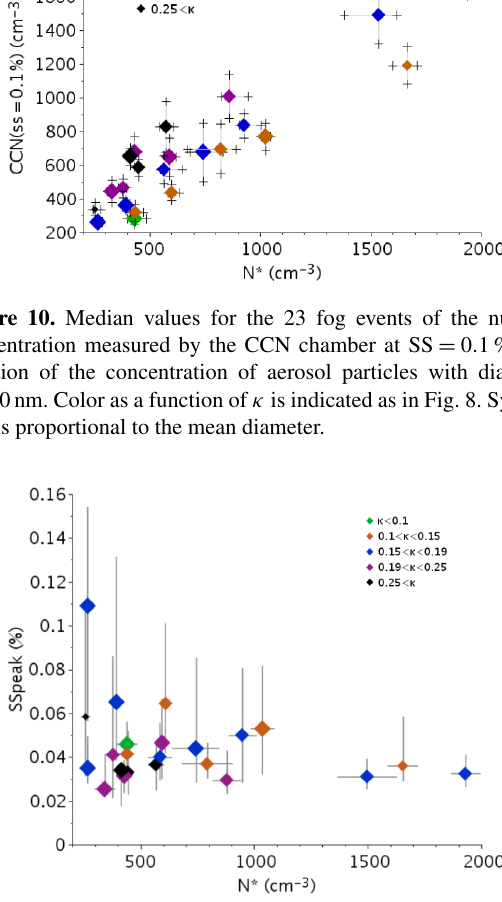
Figure 11. Critical supersaturation as a function of the concentra- tion of aerosol particles with diameter > 200nm for the 23 fog cases. Diamonds correspond to mean values and error bars to un- certainty intervals. Color and size of symbols are as in Fig. Figure 9. Number concentration of activated particles N act as a function of the critical supersaturation for the 23 fog events (black) superimposed for the statistics of CCN chamber mea- surements (grey). For CCN measurements, diamonds correspond to median values and error bars to 25th–75th percentile in- tervals. Color lines correspond to fitted results of N CCN = + 1 ;− βS 2 = CS k (blue) and CS k v,w F(µ, k , k v,w ) (red), N CCN 2 2 N CCN = N( 1 − exp ( − BS k )) (green), with parameters as indicated in the legend.